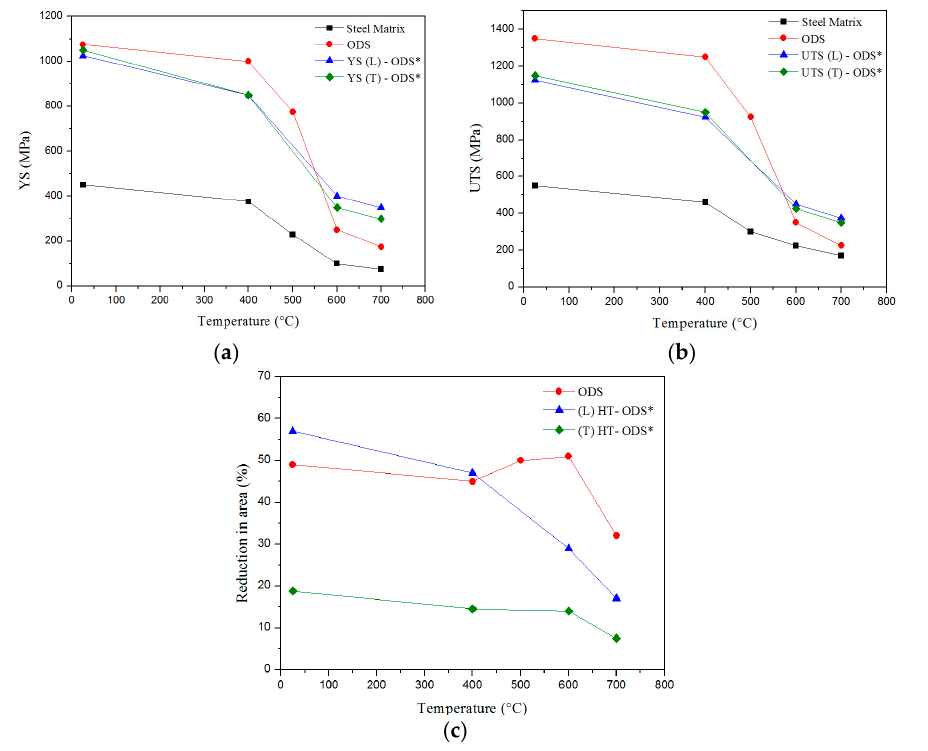
Figure 5. The tensile behavior at increasing test temperature of the examined ODS steel is compared with that of unreinforced steel (steel matrix) and of ODS*, a material prepared through the conventional route (high-energy MA/HE at 1100 °C/heat treatment of 1.5 h at 1050 °C) [28]: ( a ) Ultimate Tensile Stress (UTS); ( b ) Yield Stress (YS); and ( c ) Area reduction. Data adapted from [28] refer to samples taken along longitudinal (L) and transverse (T) directions.